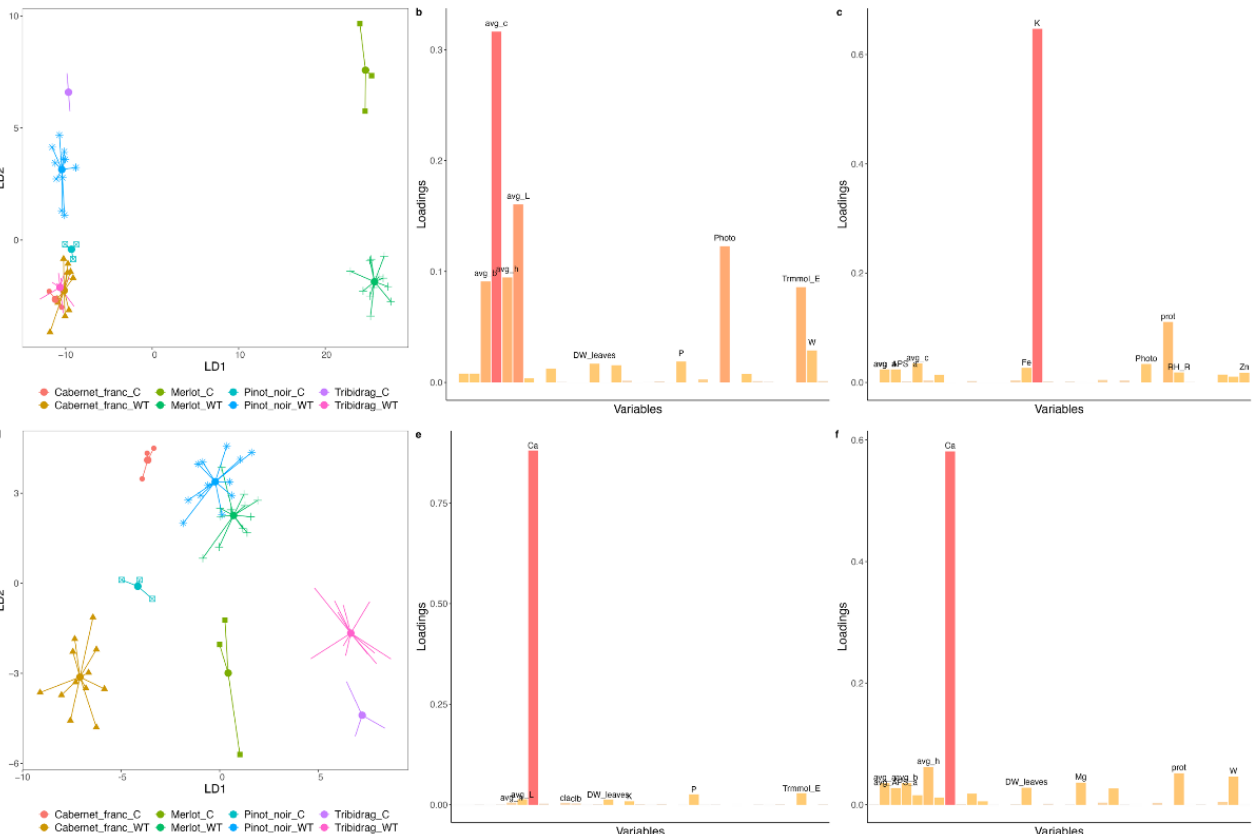
Figure 5. Plots generated by Discriminant Analysis of Principal Components (DAPC) from data collected for wild-type virus (WT) isolates in the first year of measurement in 2020 ( a – c ) and in 2021 ( d – f ); ( b , e ) represent variables that were important for the first discriminant function (LD1); ( c , f ) represent variables that were important for the second discriminant function (LD2). Abbreviations are listed in Table S1.